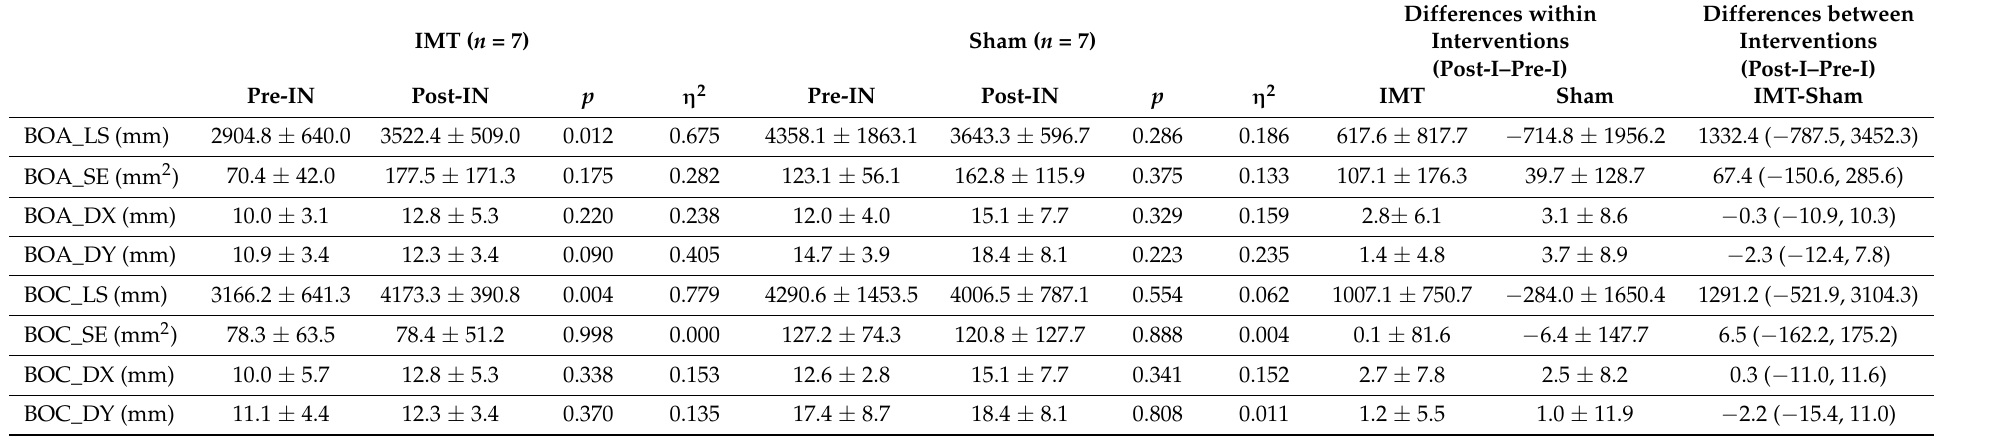
Table 2. Differences in static balance variables between groups pre–post-intervention.